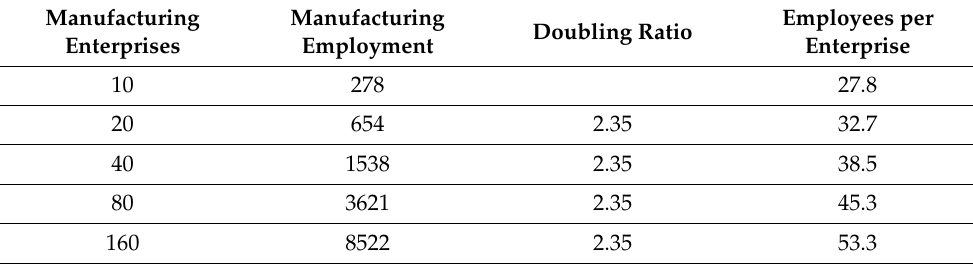
Figure 5. The power-law association between the number of manufacturing enterprises and manu- facturing employment in United States micropolitans. Table 4. Manufacturing employment in relation to the number of manufacturers in United States micropolitans. The power law in Figure 5 was used in the calculations.